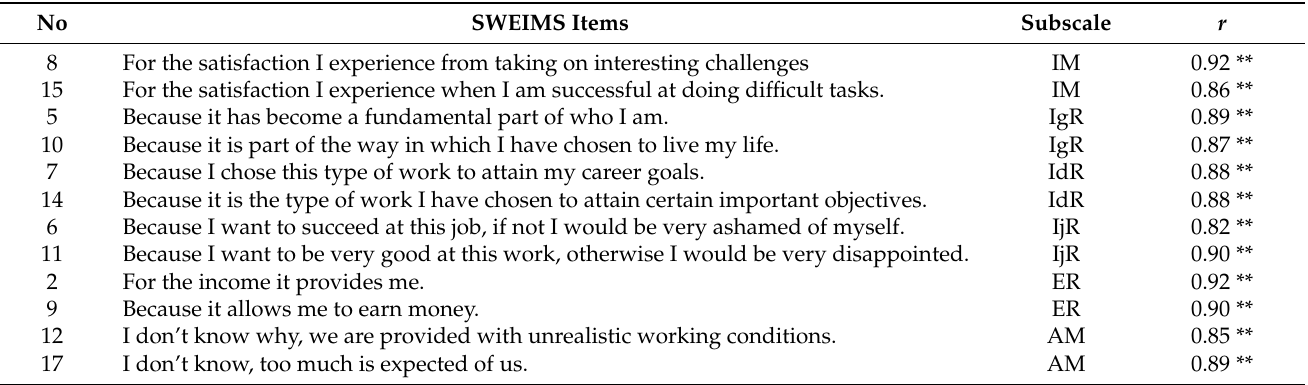
Table 1. Items for the Short Work Extrinsic and Intrinsic Motivation Scale (SWEIMS), including item-subscale correlations with subscale scores (155 construction workers).